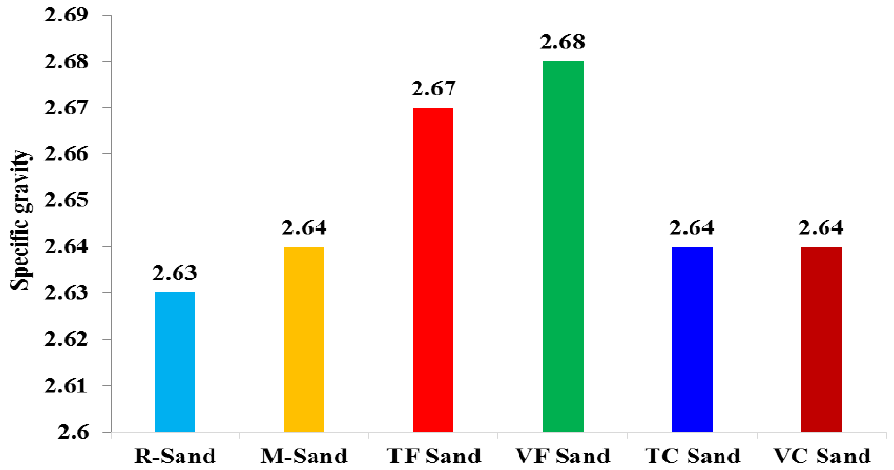
Figure 3. Specific gravity of sand samples.